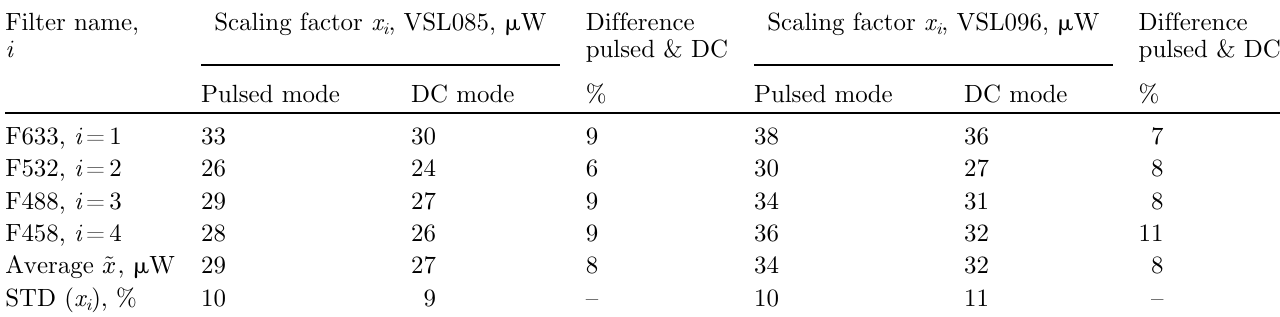
for two DUTs (VSL085 and VSL096) as estimated using equation (12). i